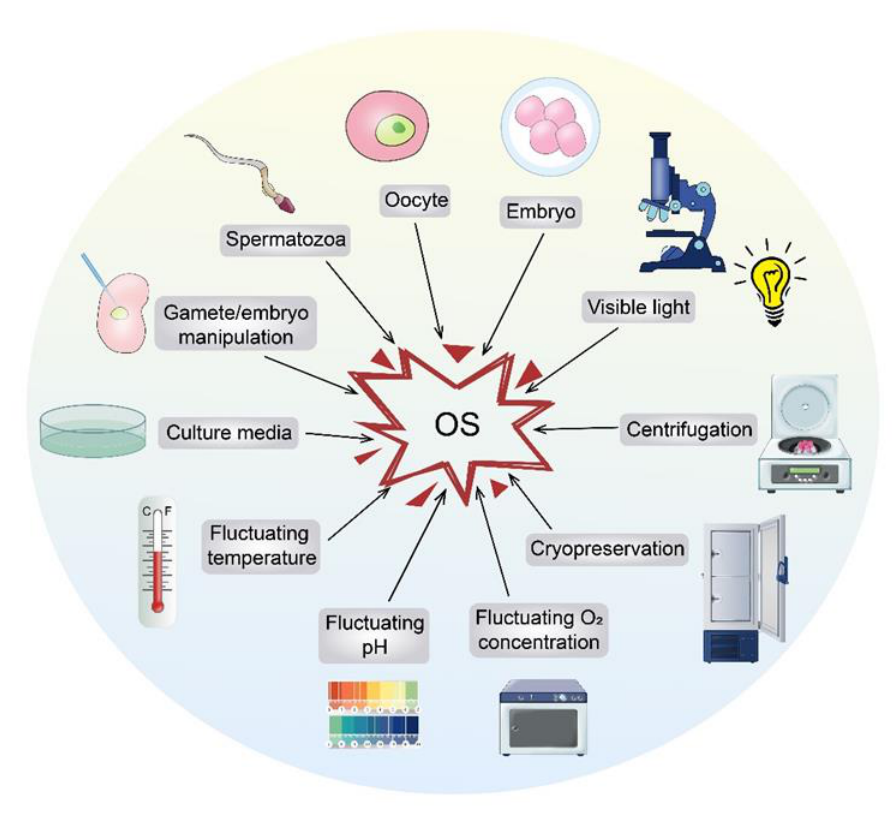
Figure 3. This figure shows the origins of ART-derived OS. During ART, several factors might lead to elevated OS. ART, assisted reproductive